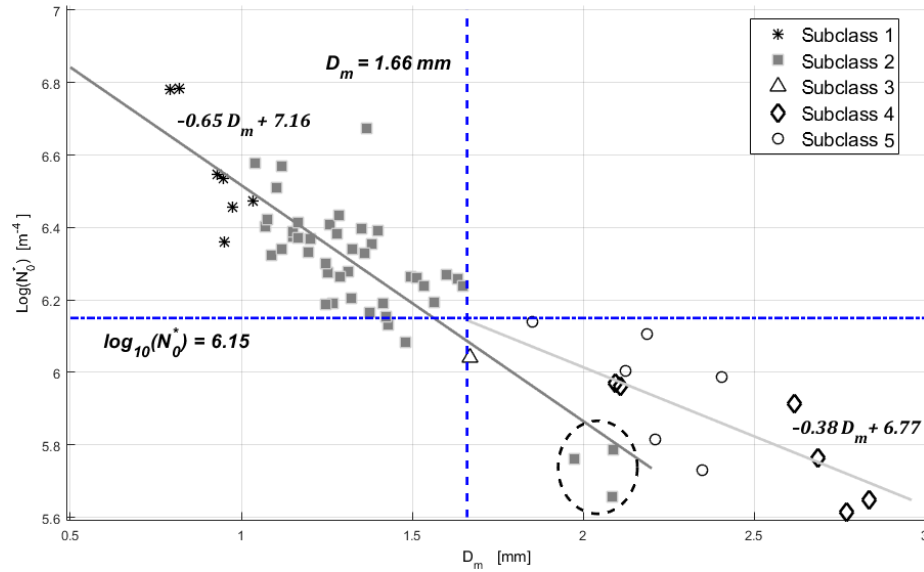
Figure 9. Microphysical variable N ∗ versus D m for the five rainy event subclasses. The three neurons corresponding to mixed events are 0 ) circled. The dashed lines correspond to borders D m >1.66 and Log( N ∗ 0